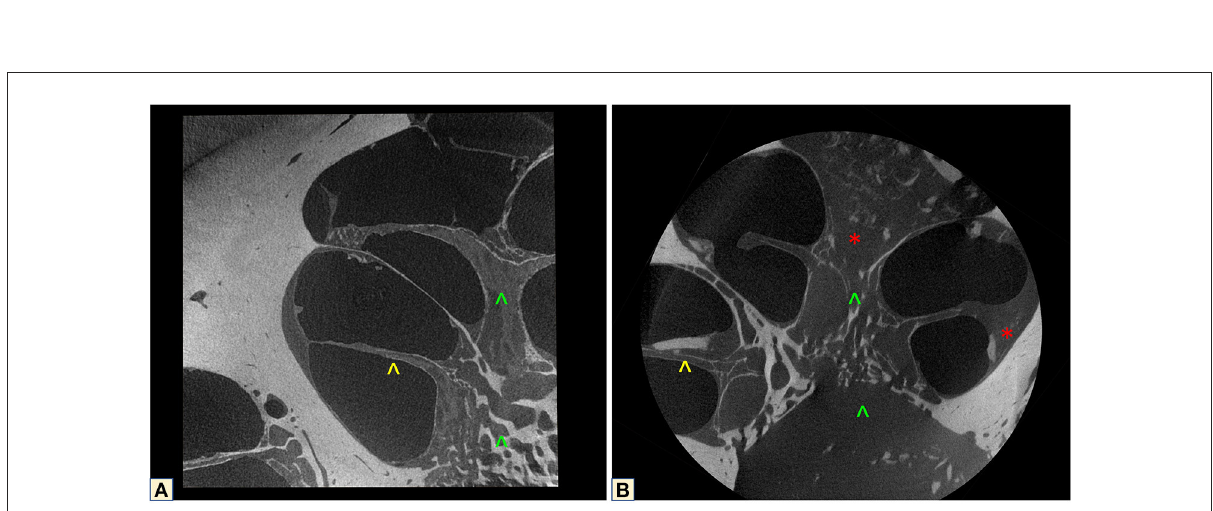
FIGURE9 MicroCT correlation between a healthy (A) and an otosclerotic cochlea (B) . Yellow arrowhead shows the normal OSL, and the disease-affected structure. Green arrowheads demonstrate the different modiolus density of the two cochleas. The red star shows the fibrotic